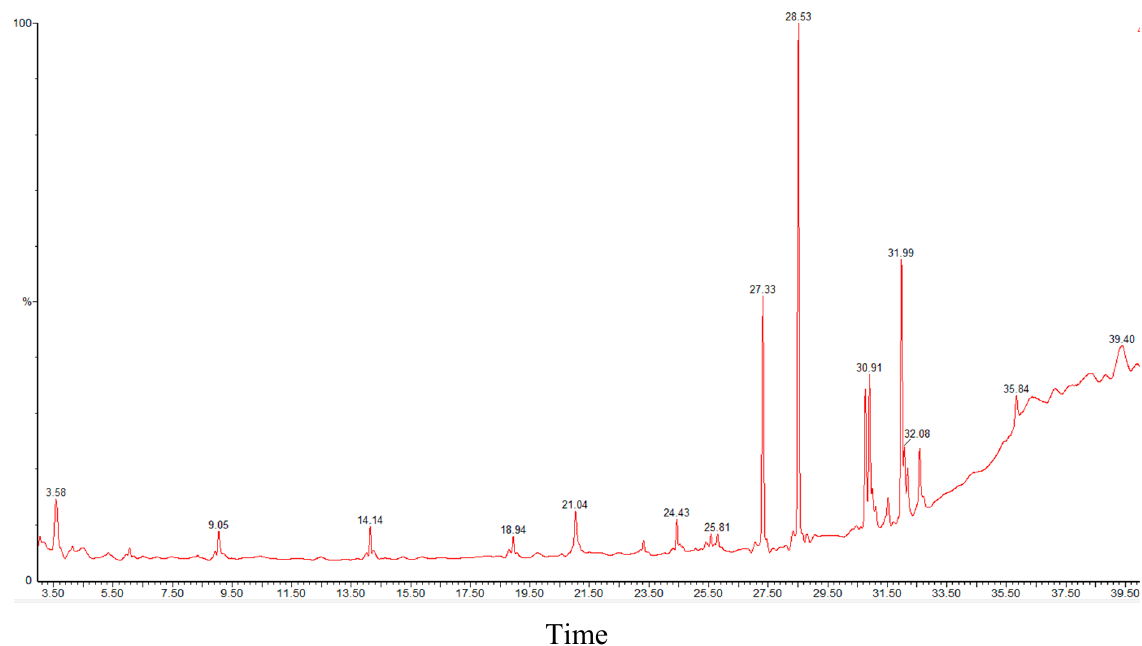
Figure 1. Gas Chromatography mass spectroscopic base chromatogram of G. tetrandra ethanol leaf extract.